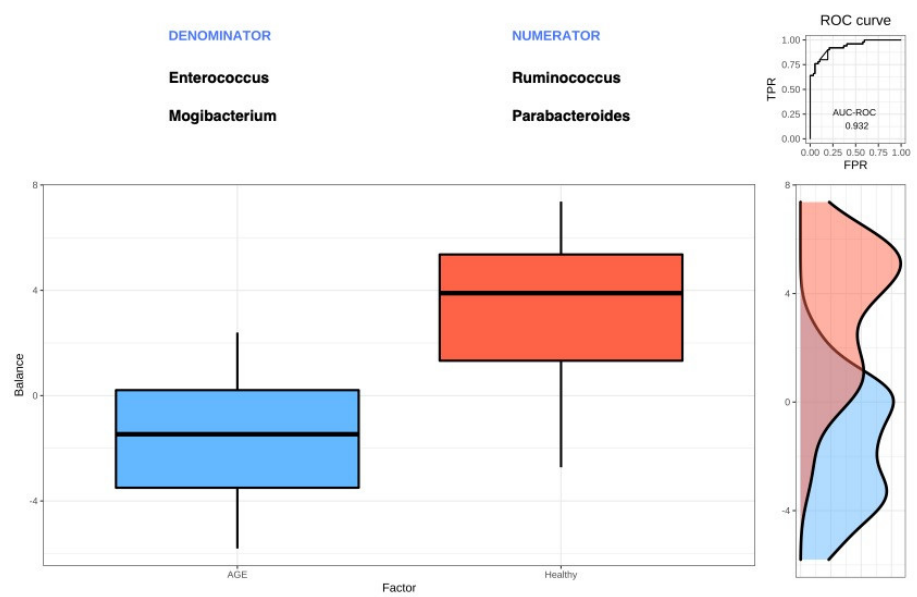
Figure 5. Global balance for AGE cases and healthy controls. The two groups of genera that form the global balance are shown at the top of the boxplot, which shows the distribution of balance scores. Boxplots show the median (middle line: 50th percentile), first (bottom: 25th percentile), and third quartiles (top: 75th percentile), and whiskers as 1.5 times the interquartile range. The right section of the figure shows the AUC-ROC curve value of 0.932 and the data density plot for each group.